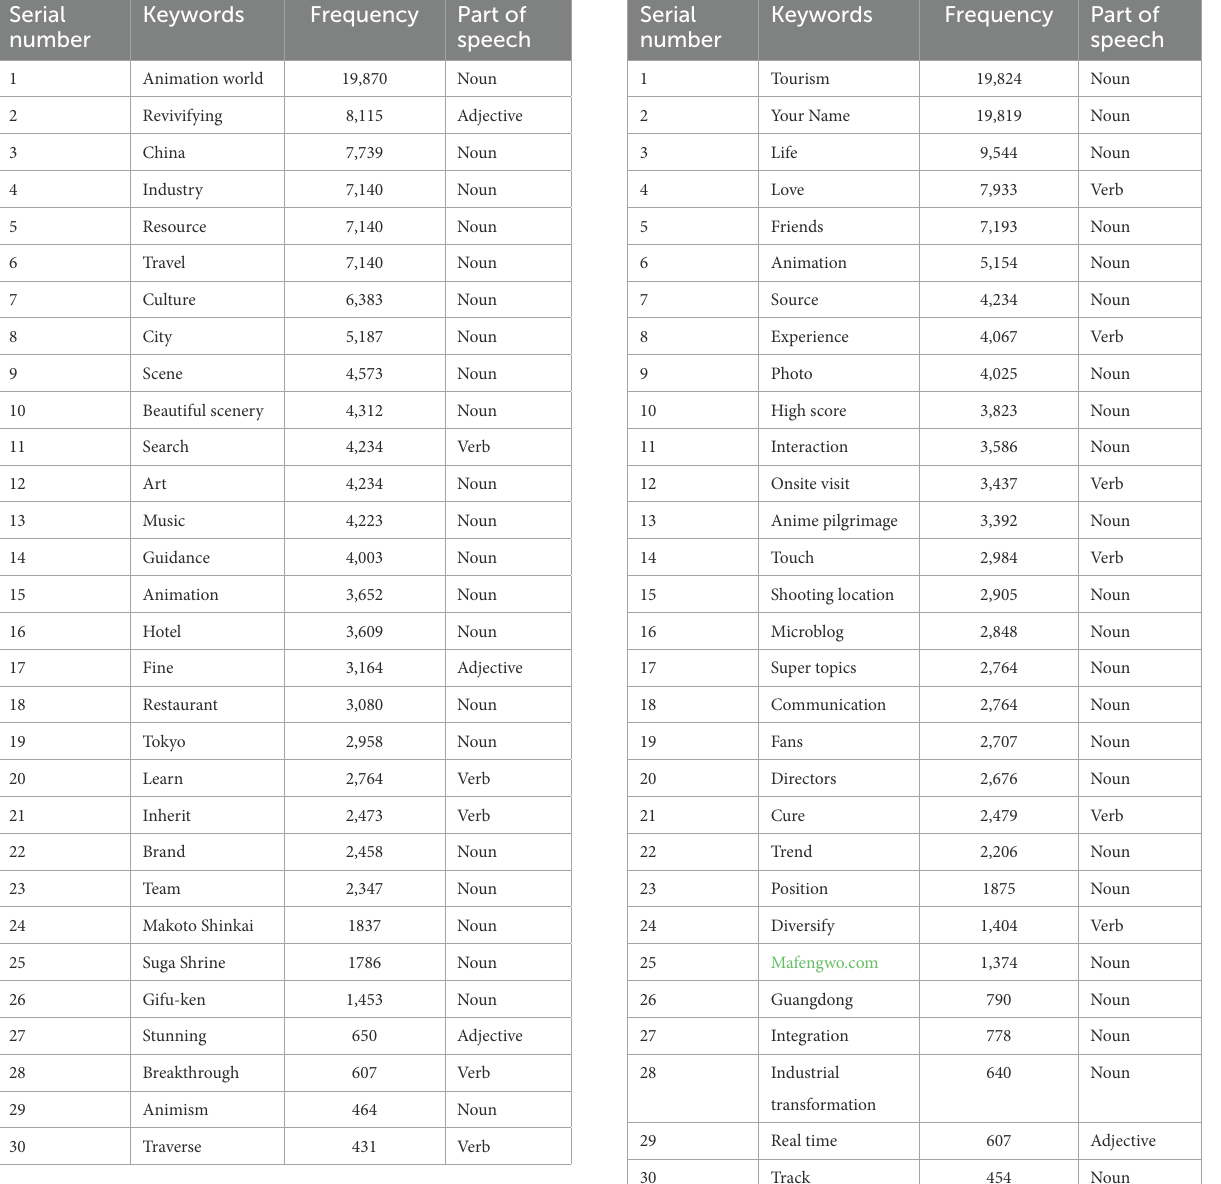
TABLE 1 Interest-related community interaction based on tourism hosts (top 30).